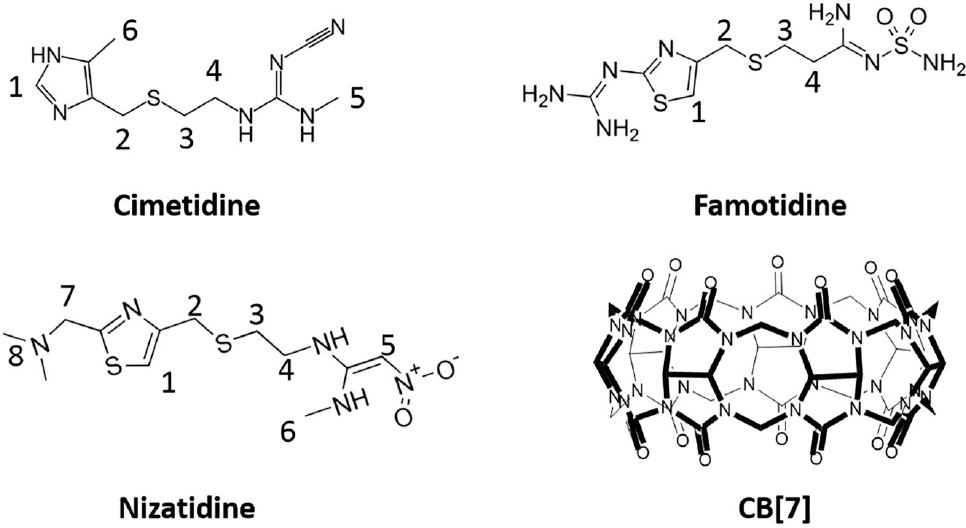
Figure 1. Molecular structures of cimetidine (CT), famotidine (FT), nizatidine (NT) and CB[7].